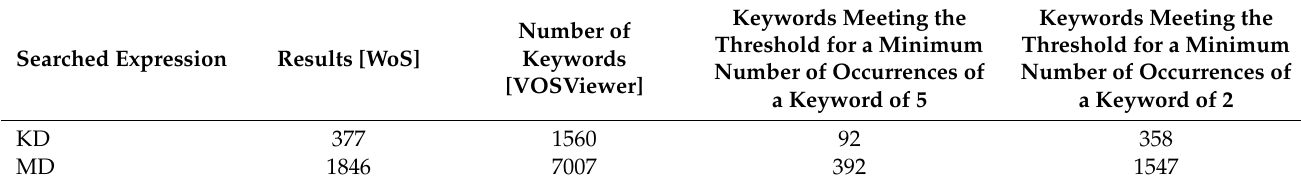
Table 4. KD and MD’s keywords meet the threshold (Source: authors’ own